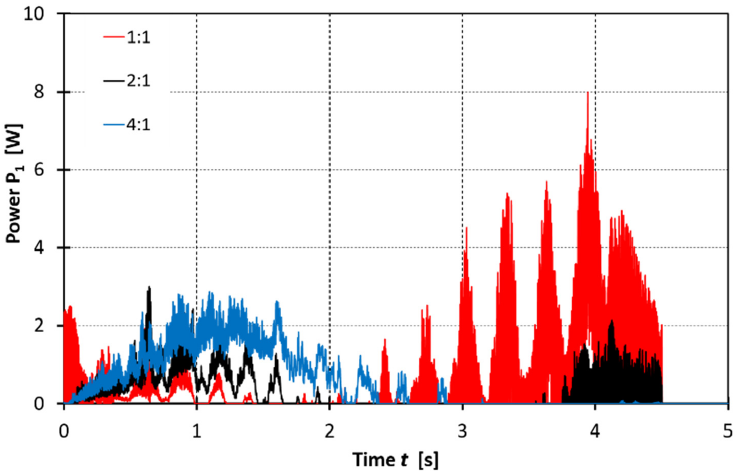
Figure 27. Sample courses of the instantaneous power consumed for the three gear ratios while reconstructing a sinusoidal profile of the arm movement.